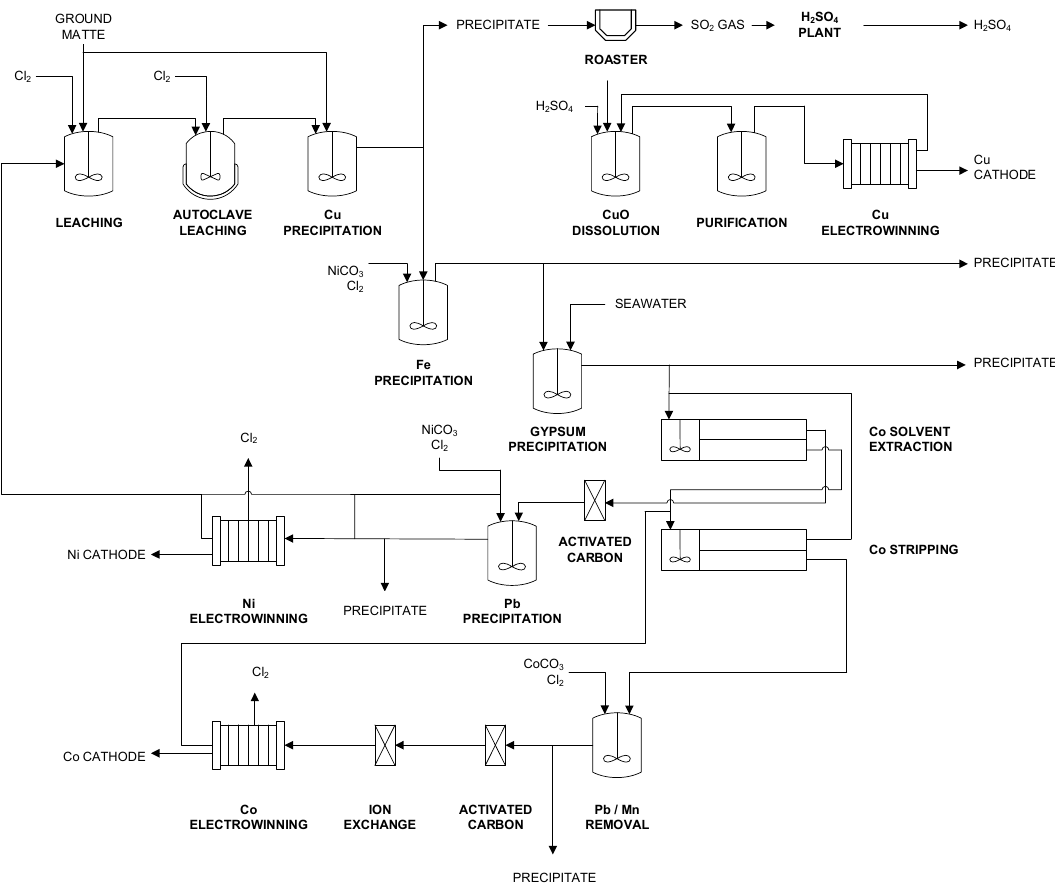
Figure 5. Simplified flowsheet of Glencore Nikkelverk AS refinery adapted from [50,51].